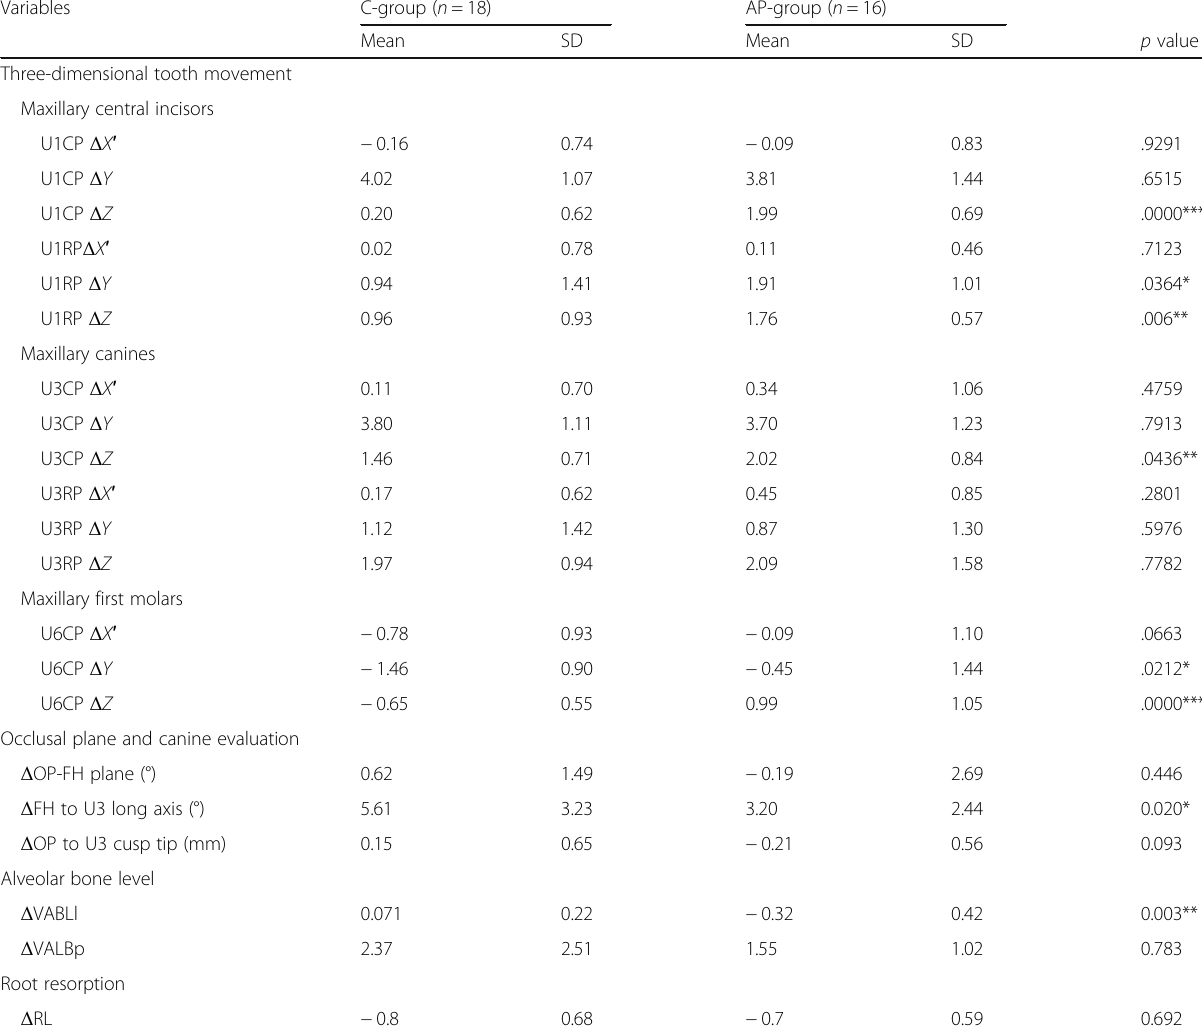
Table 3 Comparison of the changes in CBCT variables between the C-group and AP-group Variables C-group ( n = 18) AP-group ( n = 16) Mean SD Mean SD p value Three-dimensional tooth movement Maxillary central incisors